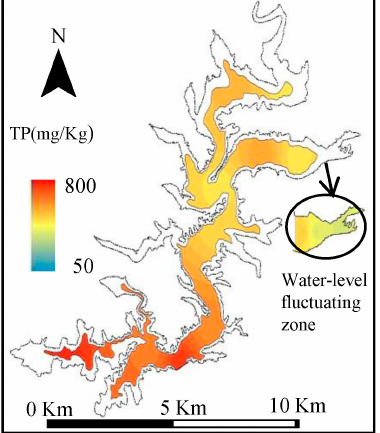
Figure 3. Distribution of TP in sediments.